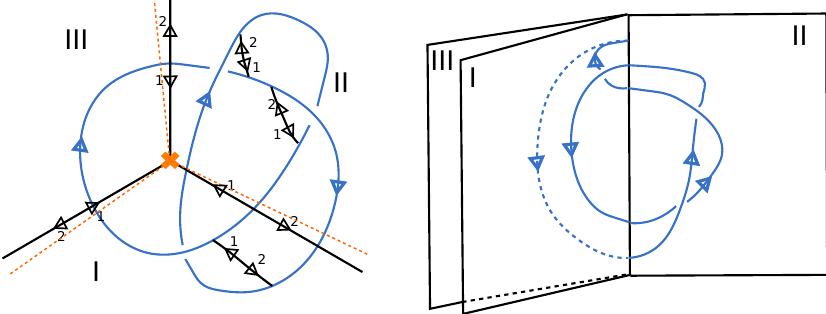
Figure 35 . A left-handed trefoil in the neighborhood of a branch point in standard projection (left) and leaf space projection (right).